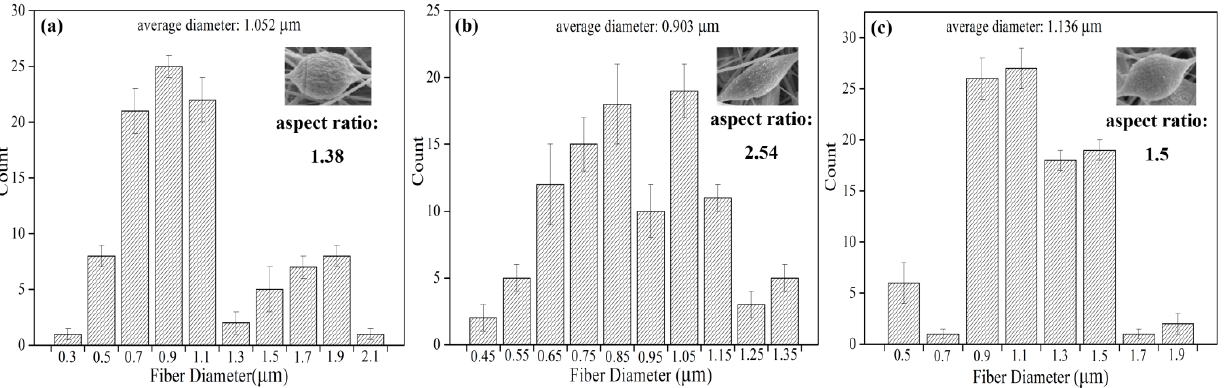
Figure 7. Fiber diameter distributions of electrospun 20 wt% PS fibers with different applied voltages ( a ) 10 kV ( b ) 15 kV ( c ) 20